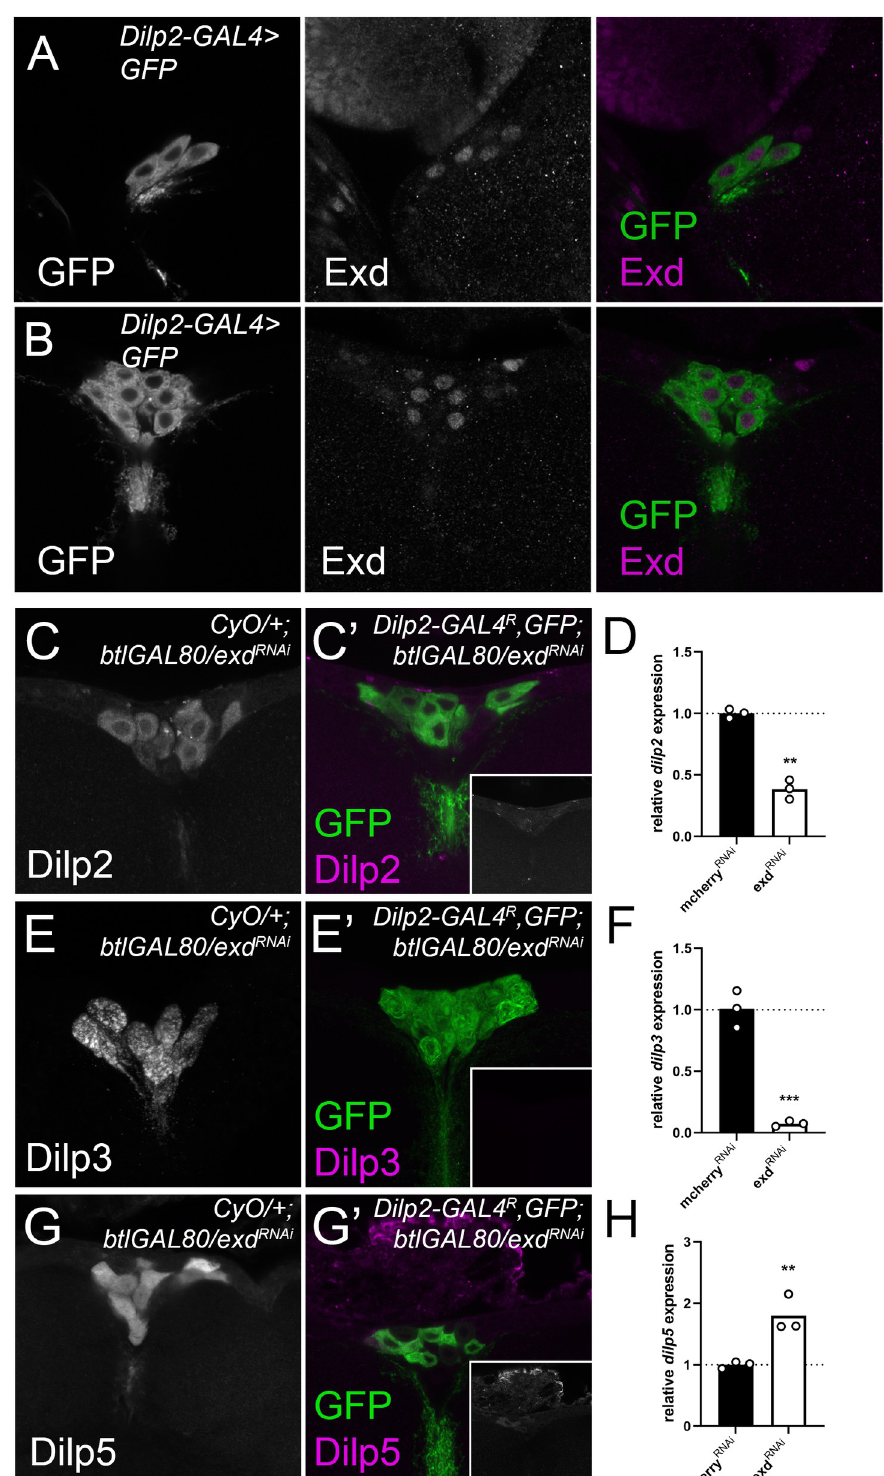
Fig 4. The Hth interactor Exd, is expressed in the IPCs and is equally required for dilp expression. (A-B) Antibodies against Exd detect expression in L3 and adult IPC nuclei, marked by dilp2-GAL4 R driven UAS-CD8GFP expression . (C-C’) Dilp2, (E-E’) Dilp3 and Dilp5 (G-G’) protein levels are reduced in adult IPCs upon Exd depletion